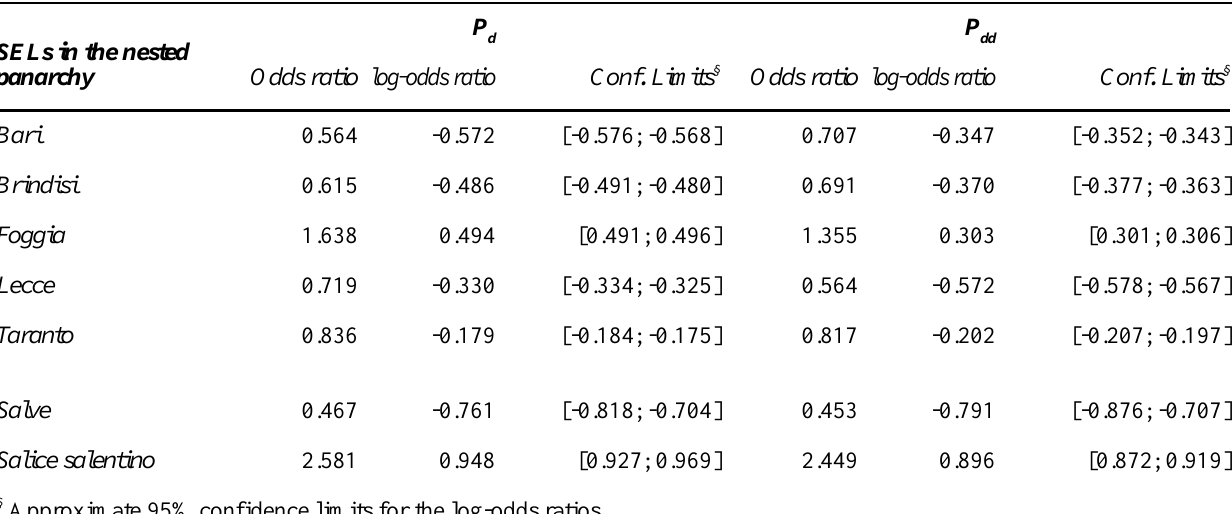
Table 2. Disturbance composition P and configuration P values defining convergence points (CPs) of d dd SELs like provinces and counties in the panarchy of Apulia (Fig. 1) with regional P = 0.10. Log-odds d ratios and approximate confidence limits are given for P and P . Log-odds ratios for provinces refer to d dd the regional CP, whereas log-odds ratios for counties refer to the CP of Lecce province (see text). P P d dd SELs in the nested Odds ratio log-odds ratio Conf. Limits § Odds ratio log-odds ratio Conf. Limits § panarchy